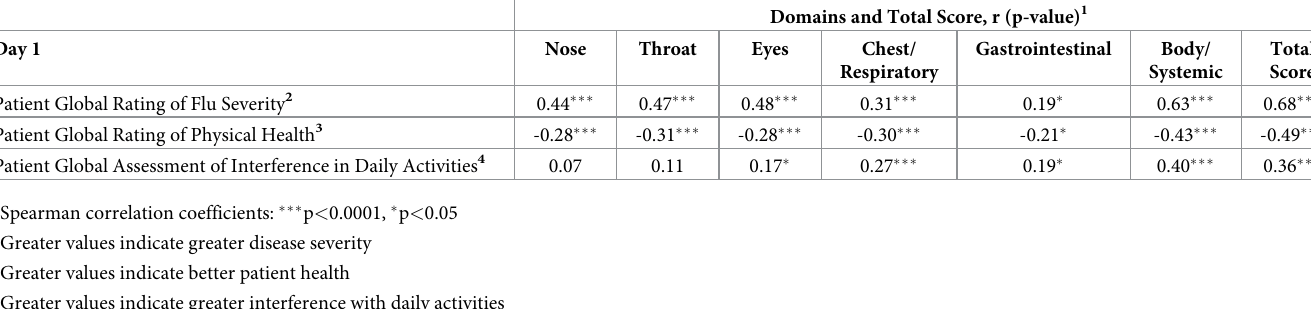
Table 4. Construct validity: FLU-PRO scale correlations with other PRO measures at Day